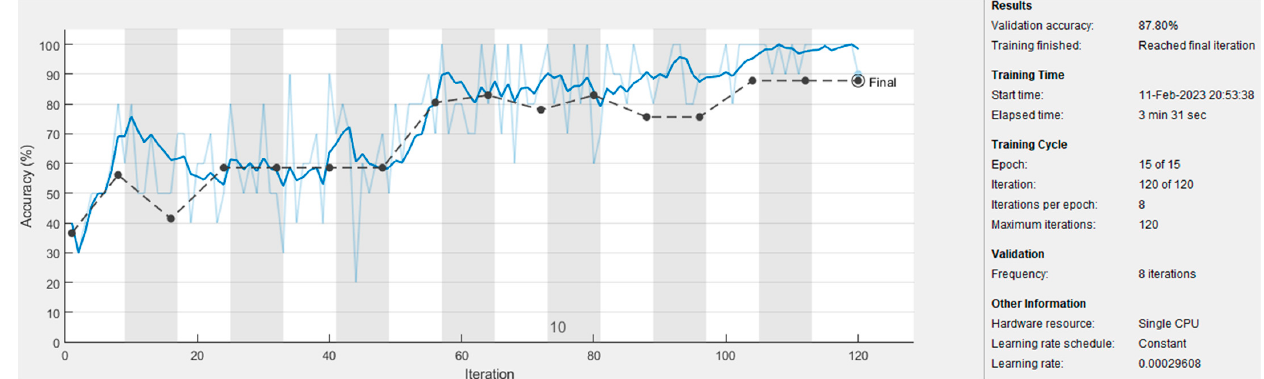
Figure 13. Confusion matrix for the training set of the proposed hybrid BA-CNN-LSTM algorithm.